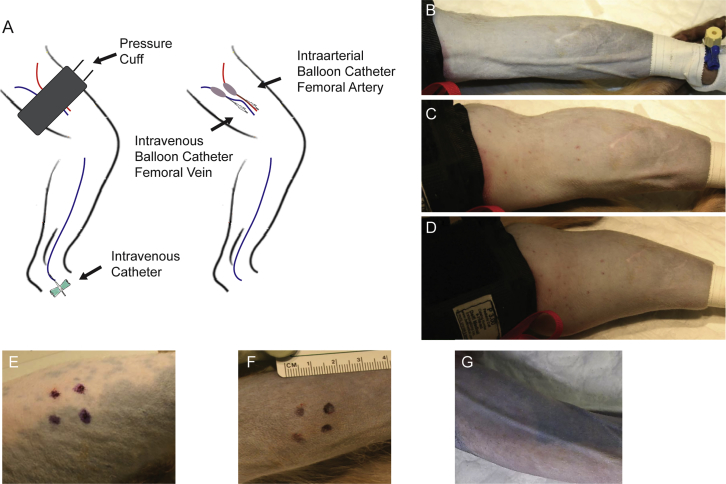
Representation of Limb Perfusion Routes and Images of the Dosed Limbs for Each Route of Delivery(A) Graphical representation of venous limb perfusion (left) and intra-arterial push and dwell (right). (B–D) VLP dosed limb (B) at the start of delivery, (C) 5 min into the vector infusion, and (D) after all vector had been infused but tourniquet had not been released. (E) Quadriceps dosing sight; note that intra-muscular (IM) injection sights are denoted using a black marking pen. The animal’s body is to the left of the image and the knee is to the right. (F) Gastrocnemius dosing sight; note that IM injection sights are denoted using a black marking pen. The animal’s knee is to the left of the image, and the foot is to the right. (G) Intra-arterial push and dwell (IAPD)-dosed limb at the end of infusion before balloon catheters deflated (the image shows the inner aspect of the dosed limb).